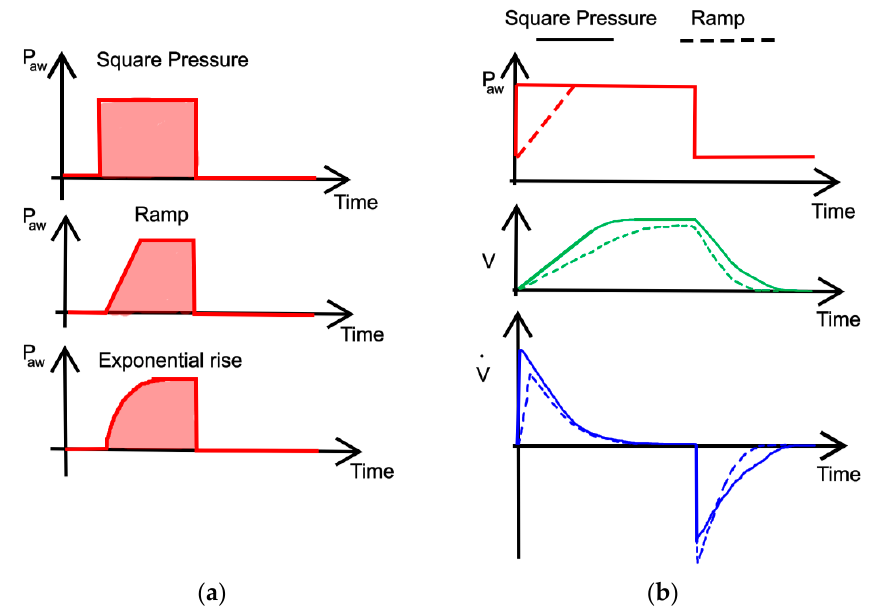
Figure 10. Various inspiratory pressure patterns typically used in PC-CMV mode ( a ) and comparison ( b ). The theoretical trends have been adapted from [46].